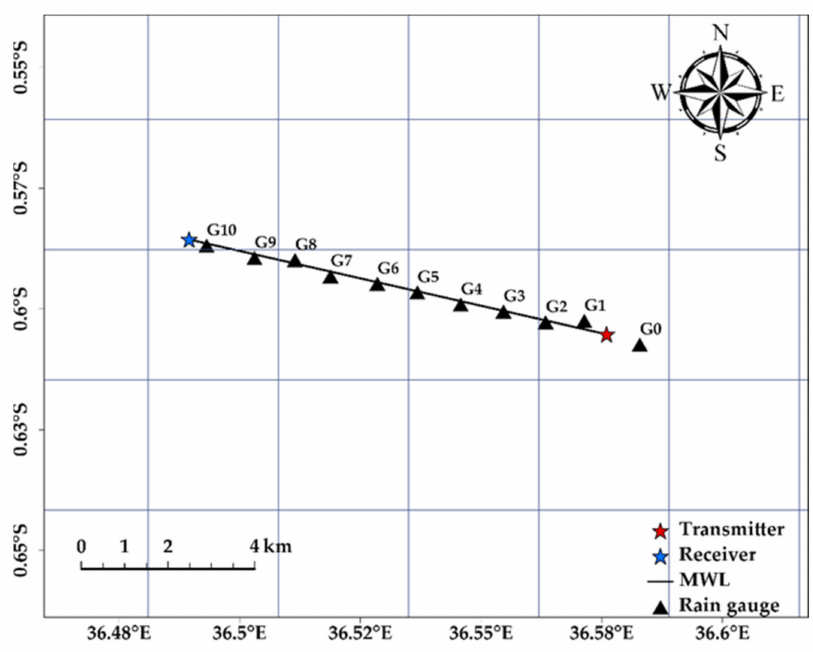
Figure 1. The MWL and rain gauges displayed in MSG